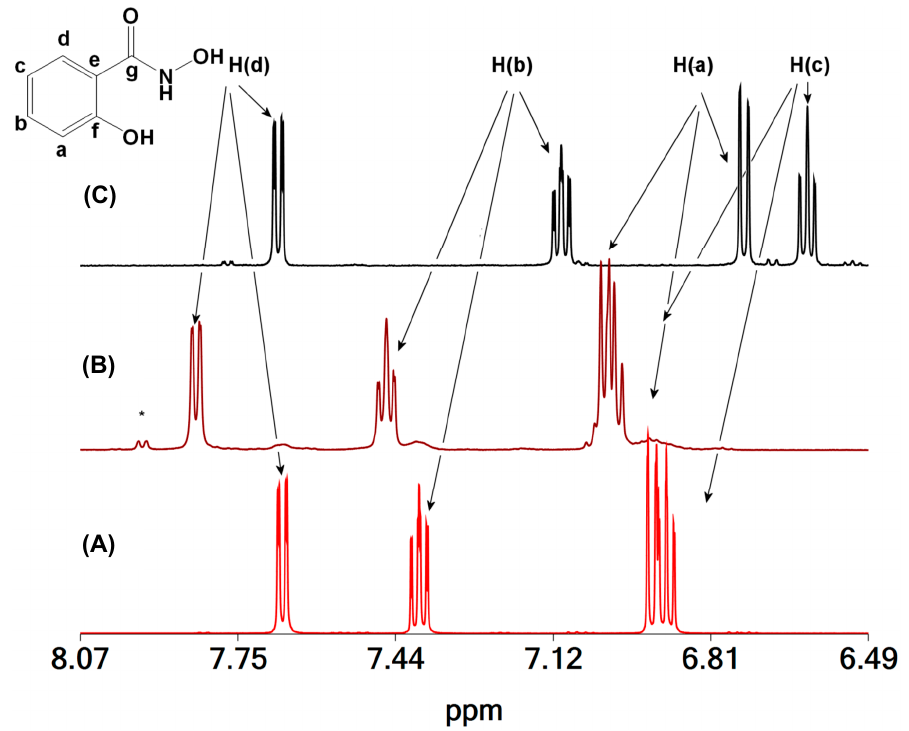
Figure 6. 1 H NMR spectra of the solutions (CD 3 OD) of the ligand H 3 dihybe ( A ); of 1 ( B ); and of 1 after the addition of two equivalents of But 4 NOH ( C ). H( a )–H( d ) are the protons of the ligand shown at the top of the Figure. * The H(d)- 1 H NMR peaks of the minor titanium complex 2 (See Supplementary Material: Table S1).